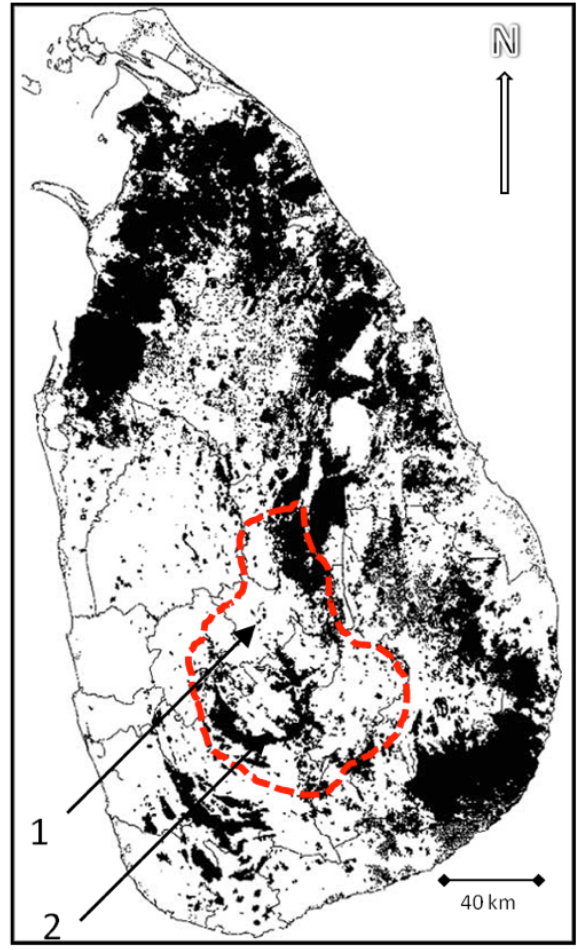
Figure 1. Map of Sri Lanka showing remaining forest cover (black). Approximate extent of central highlands is outlined in dashed red with hill country study sites indicated by arrows. 1 = Dunumadalawa forest reserve, 2 = Agrapatana study